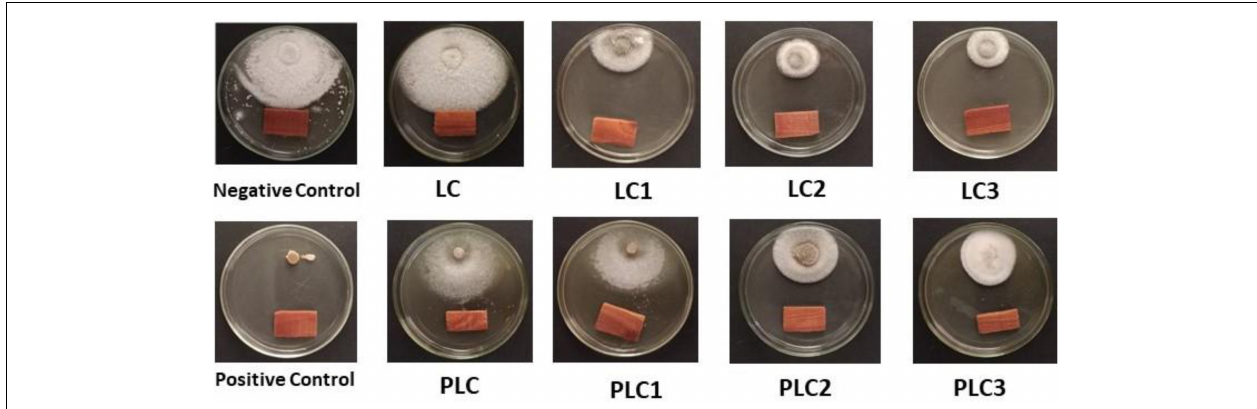
FIGURE 4 | Antifungal activity of wood-treated with 0.1% leaves and peels essential oils from Citrus limon fruits sprayed with Ag nanoparticles with different doses. Treatments of leaves: LC, AgNPs 0 mg/L; LC1, AgNPs 5 mg/L; LC2, AgNPs 7.5 mg/L; LC3, AgNPs 10 mg/L. Treatments of peels: PLC, AgNPs 0 mg/L; PLC1,